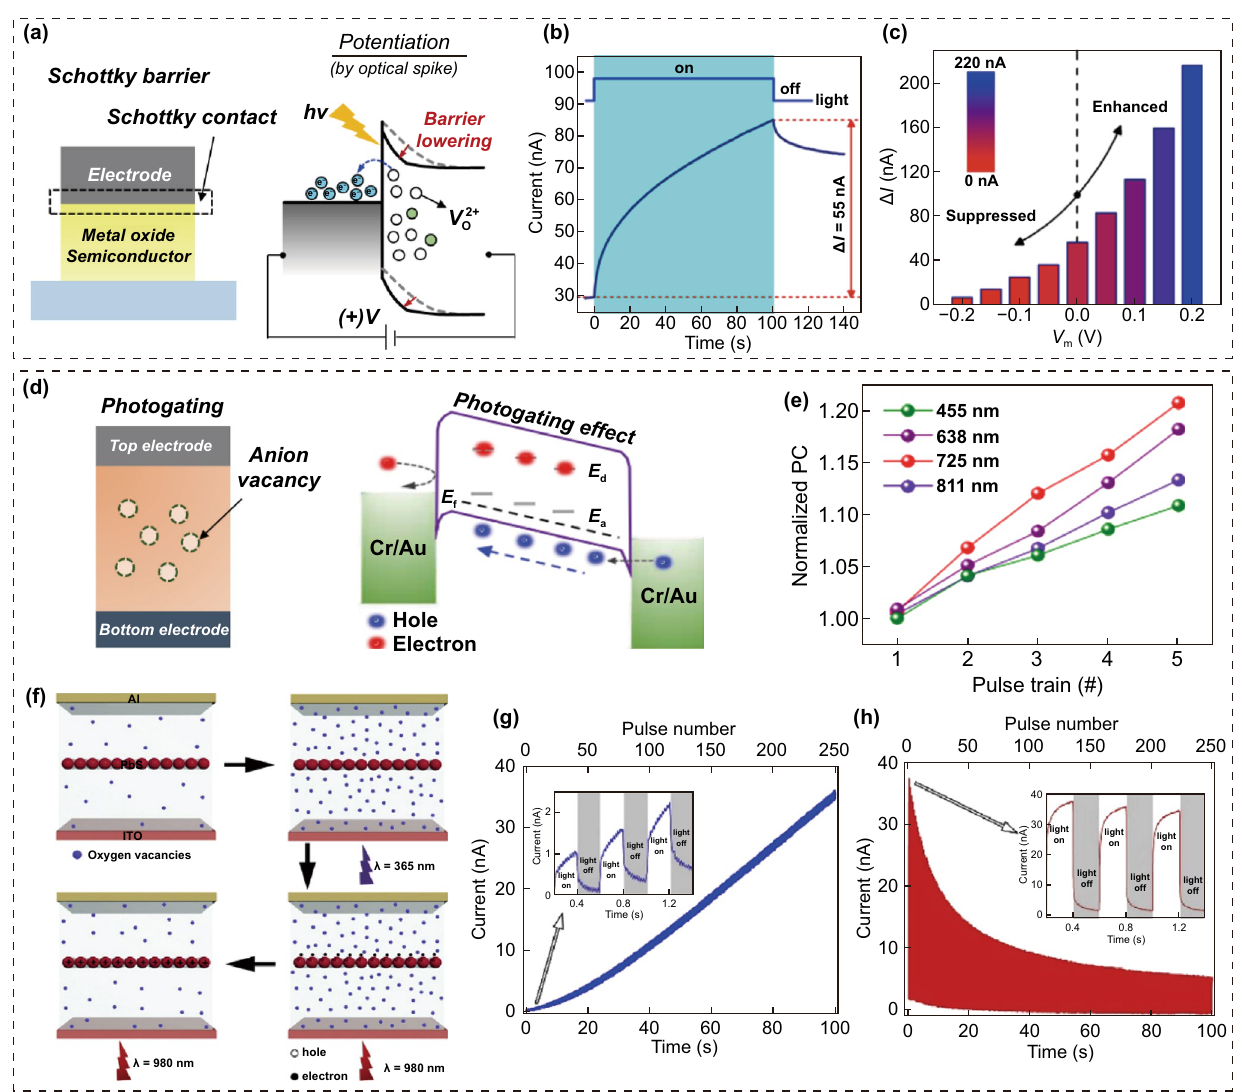
Fig. 11 Memristor‑type OSs; device configuration, operation mechanism and optoelectronic conductance switching performance. Schottky‑type memristor‑type OS; a operation mechanism, b optical potentiation, and c conductance switching performance engineering using bias modula‑ tion. Photogating memristor‑type OS with antimony vacancies; d operation mechanism and e optical potentiation as a function of light wave‑ length. Fully optically modulated photogating memristor type OS with oxygen vacancies and QDs; f operation mechanism, g UV light‑driven potentiation, and h IR light‑driven potentiation. b , c Reproduced with permission from Ref. [86]. Copyright @ 2019, American Chemical Soci‑ ety. d , e Reproduced with permission from Ref. [87]. Copyright @ 2021, AAAS. f – h Reproduced with permission from Ref. [91]. Copyright @ 2019,